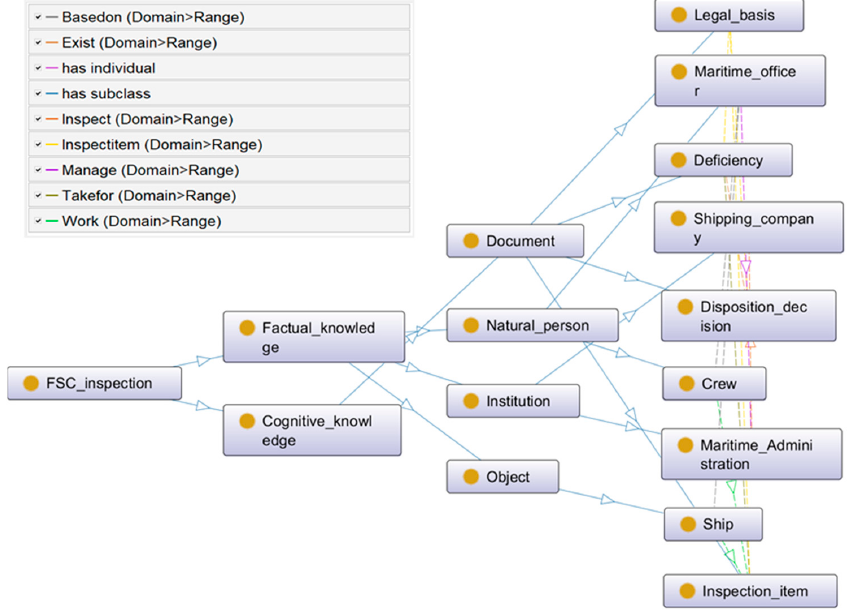
Figure 4. The ontology model of the FSC inspection.